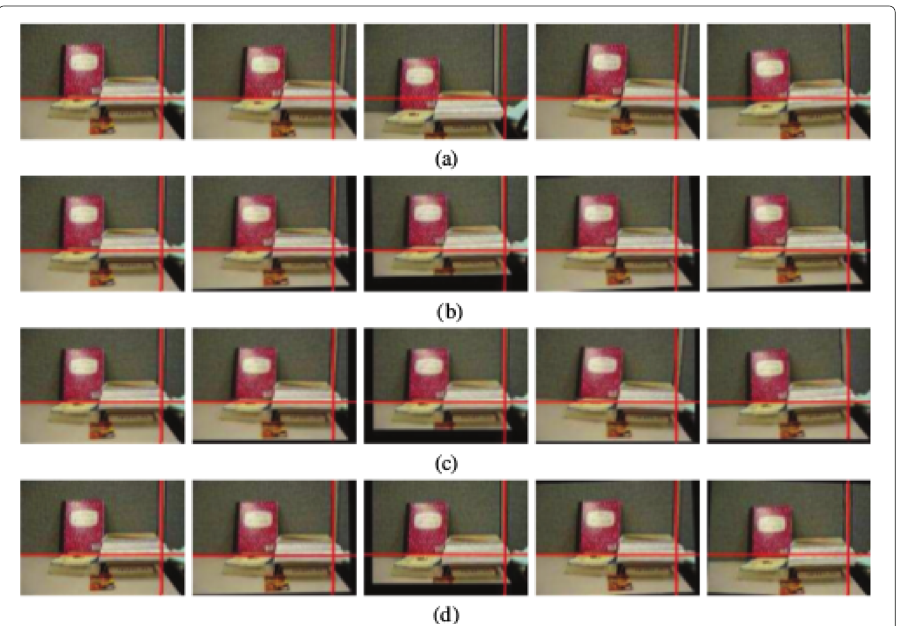
Fig. 2 Sequence of video frames. a Original video. b – d Different versions of the stable video. Extracted from